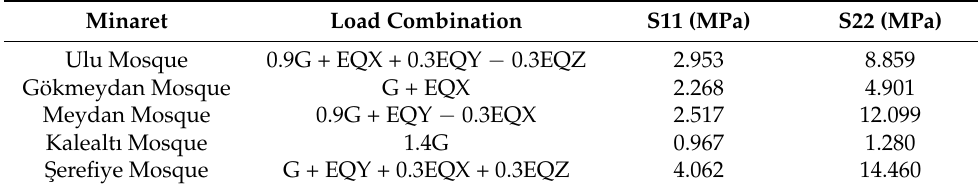
Table 7. Maximum compressive stresses obtained for Five Minarets.